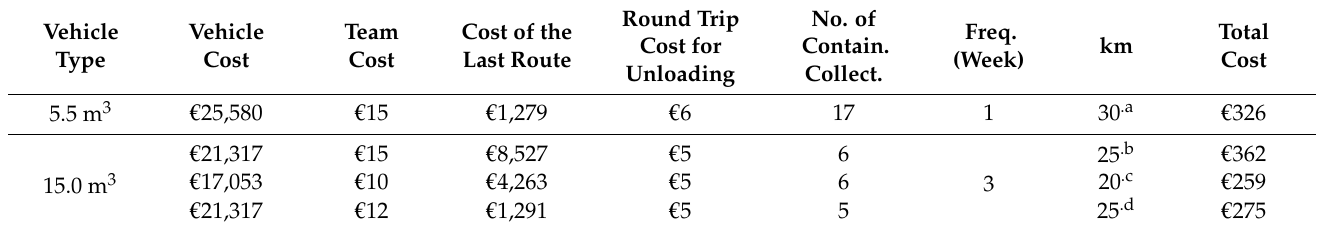
Table 1. Collection and transport cost for the Micro and the tri-flow vehicle (route/vehicle).